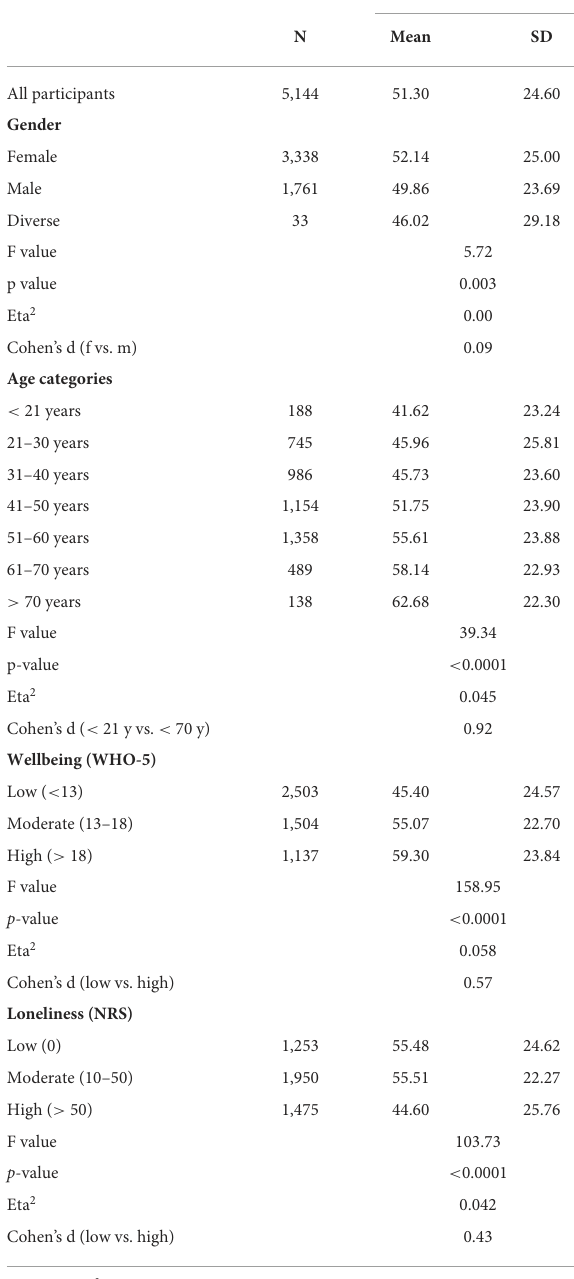
TABLE 3 Frequency distribution with group comparisons for sociodemographic